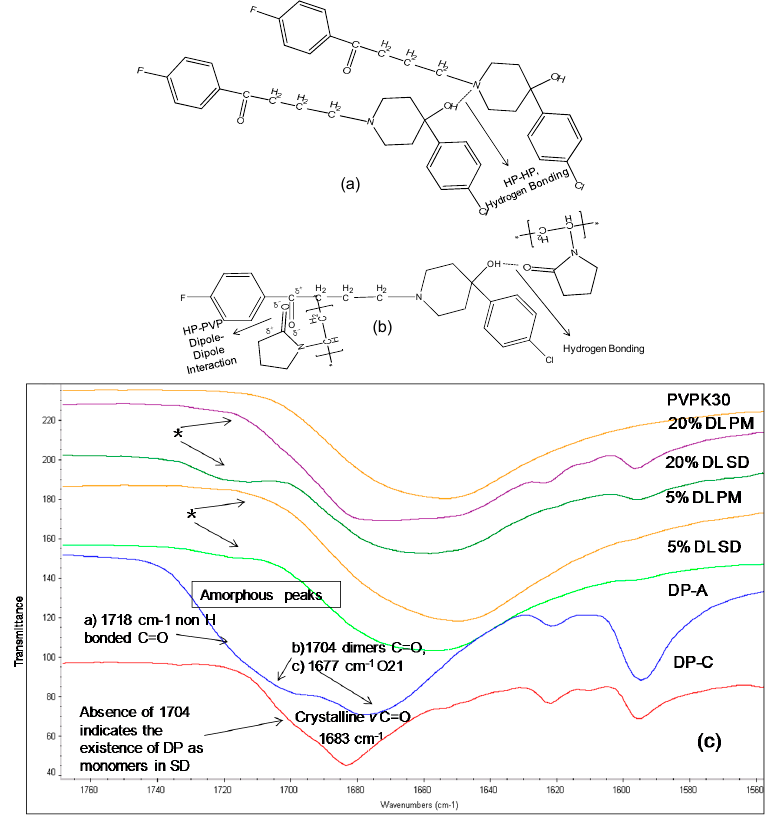
Figure 7 . (Top a , b ): Schematic representation of ( a ): Intermolecular hydrogen bonding in DP. Two molecules are linked together by two hydrogen bonds, linking the benzimidazole terminals through N8H and O1 atoms ( b ): Hydrogen bonding and dipole dipole interaction between DP and PVPK30 (bottom c ) FTIR spectra of droperidol (DP), crystalline (C), amorphous(A), PVPK30 solid dispersion (SD) and physical mixture (PM) at 1680 cm − 1 1677 cm − 1 (O21), 1704 cm − 1 (C=O, (O1) in dimers) and 1718 cm − 1 ( non-hydrogen bonded C=O, (O1)). The 1704 cm − 1 correspond to O1 in dimer structure. * The peak disappearing in the solid dispersions indicating the lack of the dimers in the solid dispersion.